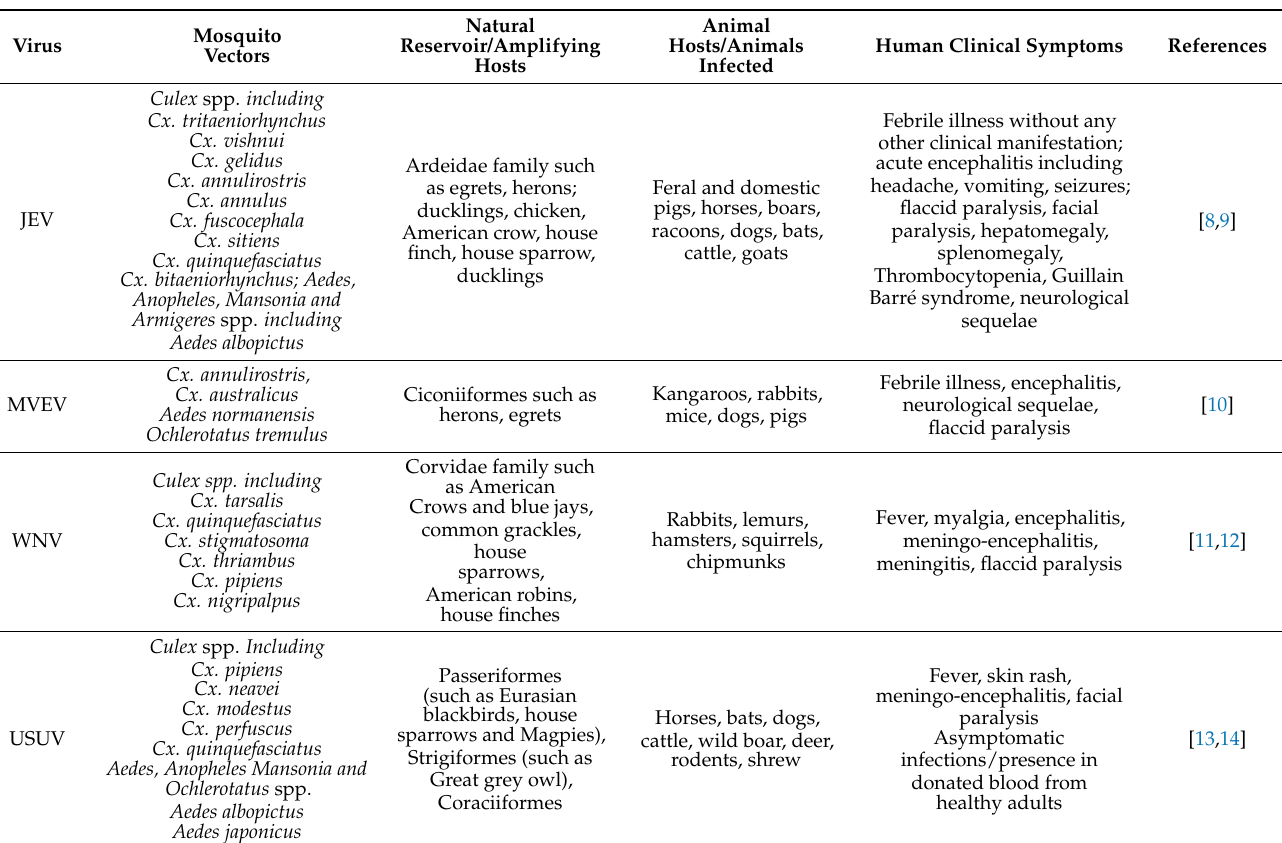
Table 1. Listed are some vectors and animal hosts of the four viruses from Japanese encephalitis serocomplex and the clinical symptoms in human